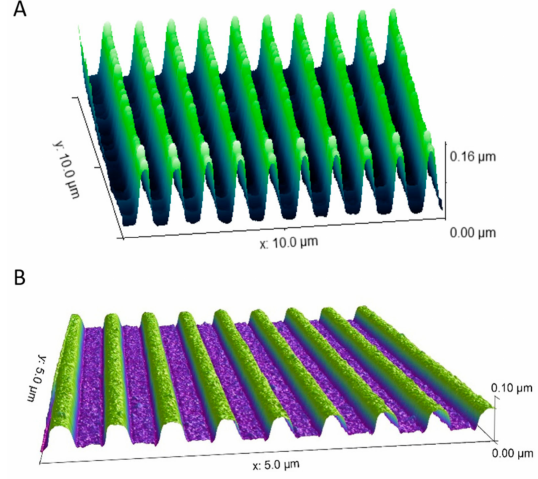
Figure 3. AFM measurements on nanogrooved PDMS substrates. ( A ) Nanogrooved pattern with a ridge width of 246 ± 22 nm and a pattern periodicity of 990 ± 22 nm (n = 5). This pattern was used for SH-SY5Y cell culture experiments. ( B ) Nanogrooved pattern with a ridge width of 219 ± 5 nm and a pattern periodicity of 587 ± 0 nm (n = 5). This pattern was used for primary rat brain cortical cell culture